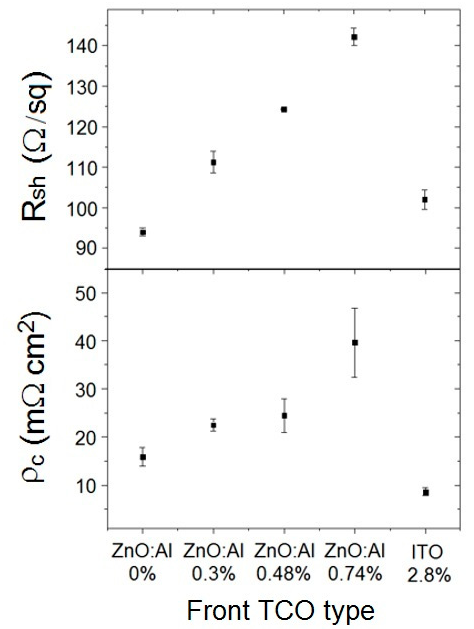
Figure 4. ρ c and R sh obtained from transmission line method (TLM) measurements on the front side of rear emitter SHJ structures with ITO 2.8% as a reference and ZnO:Al as the front TCO deposited under different oxygen partial flows. Each item on the horizontal axis represents a group of samples, with the material for the front TCO and the oxygen partial pressure under which it was deposited.